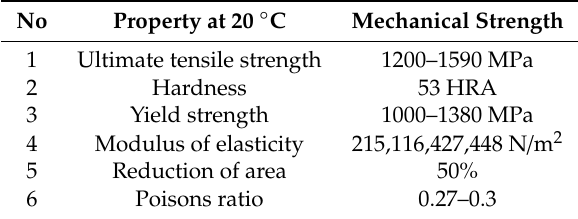
Table 5. Chemical composition of H13 tool steel [32].